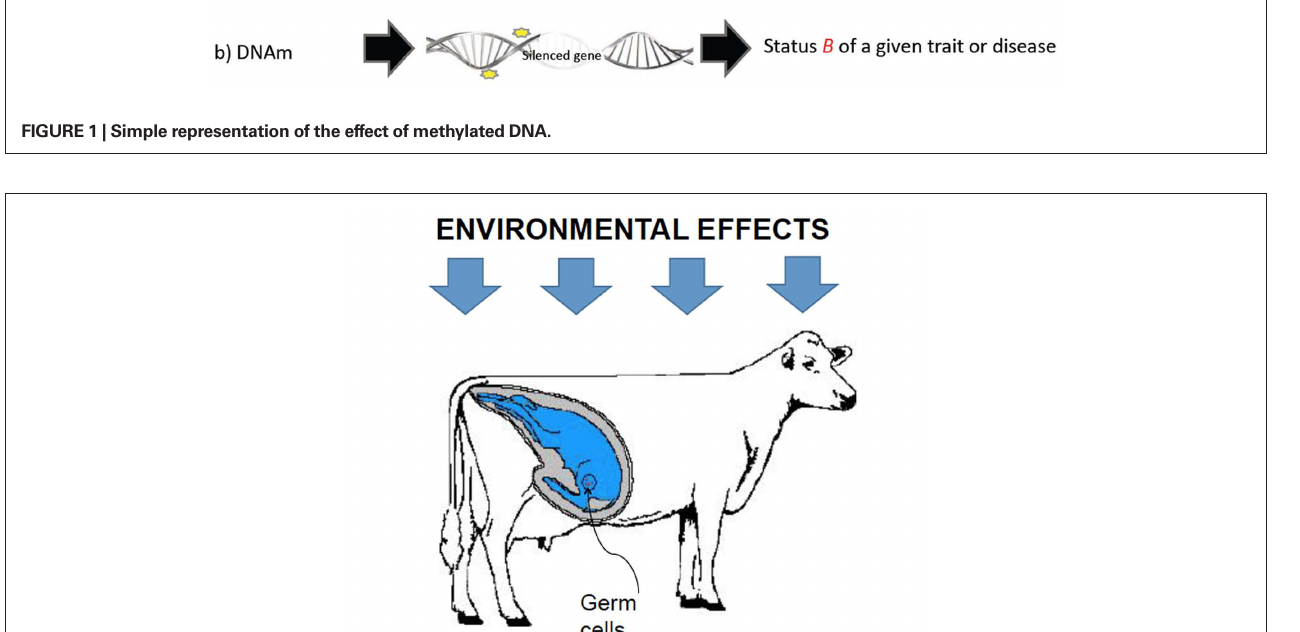
Figure 2 | environmental forces at time t , may affect the methylation patterns of three